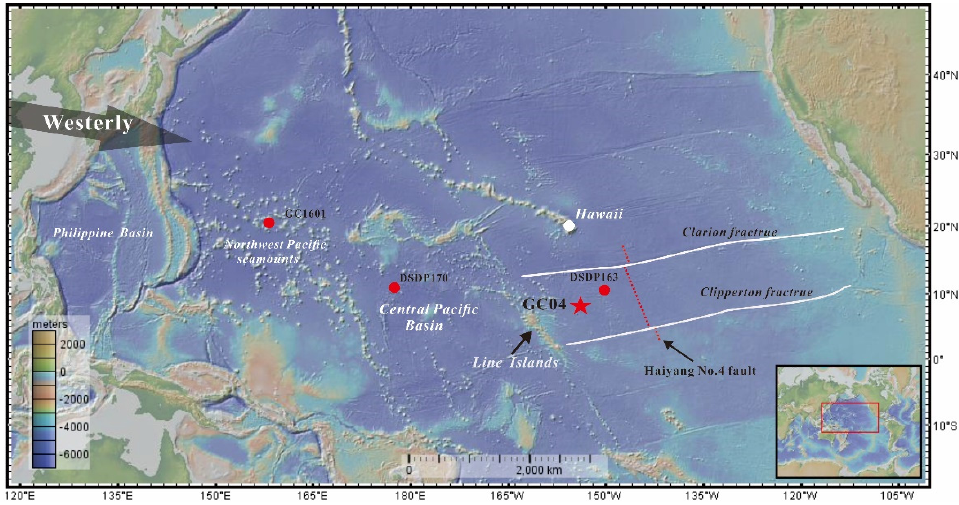
Figure 1. Core sampling location of GC04 in western Clarion Fracture Zone and other reference samples (GC1601, DSDP Site 170, DSDP Site 163). Gray arrow indicates directions of the westerly jet stream associated with the migration of terrigenous eolian dust. The map was created using GeoMapApp.